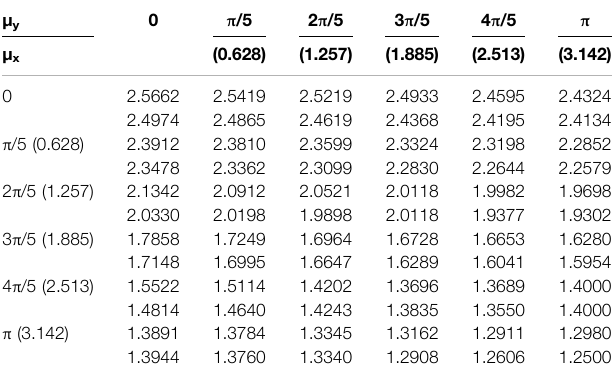
TABLE 2 | Nondimensional frequencies ( Ω ) for a periodic plate (orthogonal line- supported) with the rectangular element.